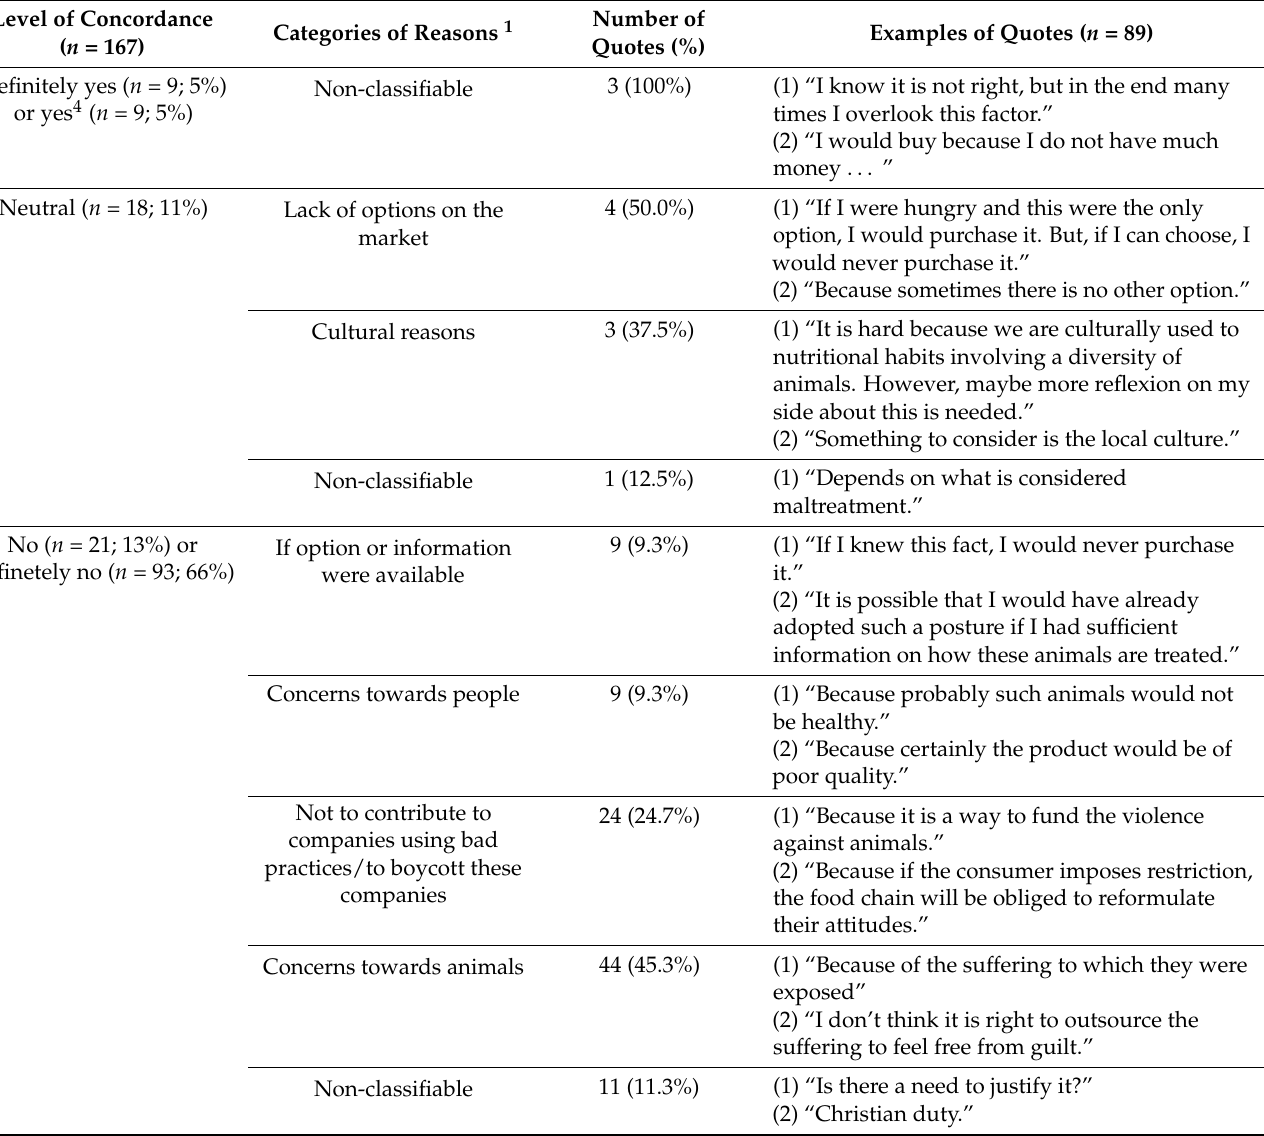
Table 6. The level of agreement on a five-point scale, from definitely yes to definitely no, regarding the intention to purchase food from animals who were maltreated and reasons given by citizens of Porto Alegre, South Brazil, from September